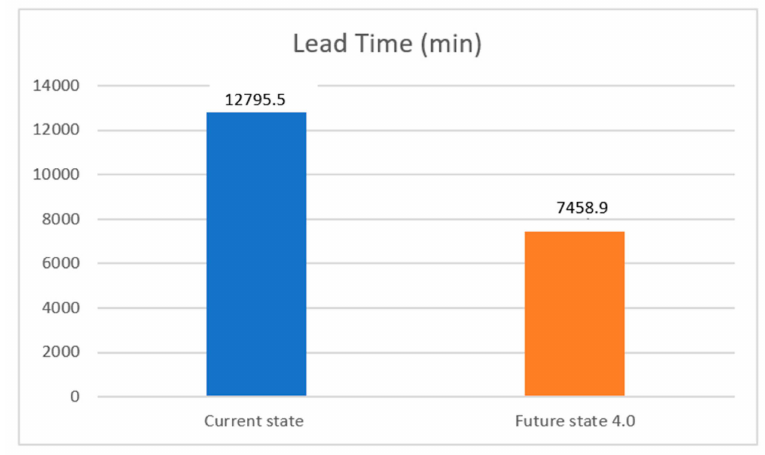
Figure 8. Comparison between Time to Value Added current and future state.